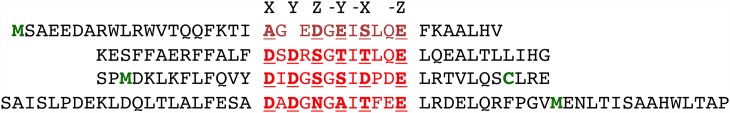
Sequence of the fragment 1–169 of Human NOX5 (isoform β) with four aligned EF-hand calcium-binding motives.Canonical EF-hand motives are shown in red, and non-canonical (with deletion at position Y) in brown. Amino acids which are involved in calcium binding (in positions 1, 3, 5, 7, 9 and 12 of motives) are underlined and are denoted by X, Y, Z, -Y, -X and -Z. Met1, Met 77, Cys107 and Met155 residues subjected to oxidation are shown in green.